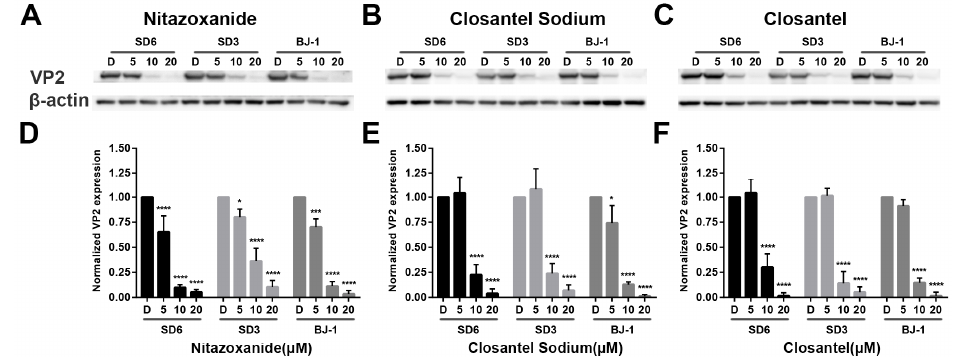
Figure 6. Potential broad-spectrum anti-CPV activity of identified drugs. F81 cells were seeded in 6-well plates and pretreated with 5 µ M, 10 µ M, or 20 µ M of Nitazoxanide ( A ), Closantel Sodium ( B ), or Closantel ( C ) for 1 h, respectively. Then treated cells were infected with various CPV strains SD6, SD3 or BJ-1. Cells were harvested and lysed at 40 hpi for western blot analysis. Band intensities were then measured using software Image J, and VP2 expression was analyzed and compared to beta Actin expression. Relative expression levels for Nitazoxanide- ( D ), Closantel Sodium- ( E ), and Closantel ( F )-treated results are presented in bar graphs. Error bars represent standard errors from three independent experiments. Statistical analysis was compared to Control (0.1% DMSO-treated cells, marked as D in the figure) and carried out using one-way ANOVA and Dunnett’s multiple comparisons test. * p < 0.05; ** p < 0.01; *** p < 0.005; **** p < 0.001.